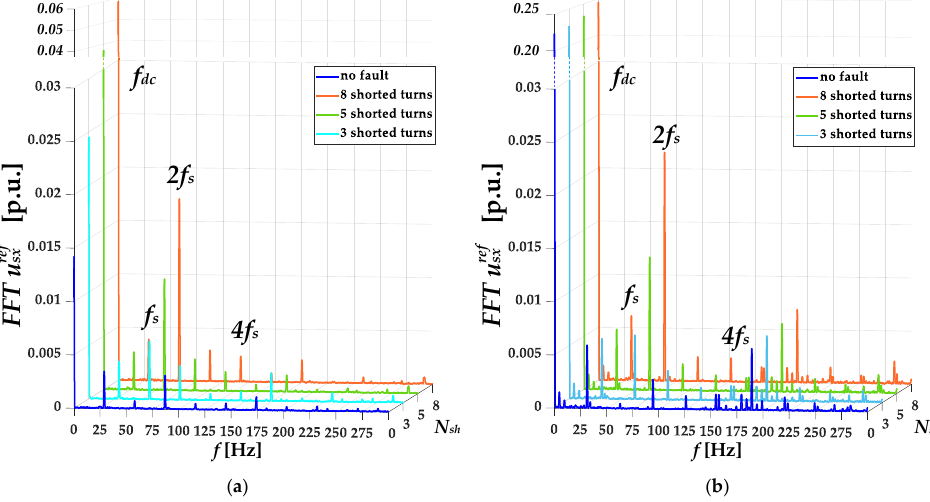
Figure 10. Spectral analysis of reference u sx voltage with several short-circuit turns with ω m = 0.6 ω mN for ( a ) no-load operation and ( b ) nominal load operation